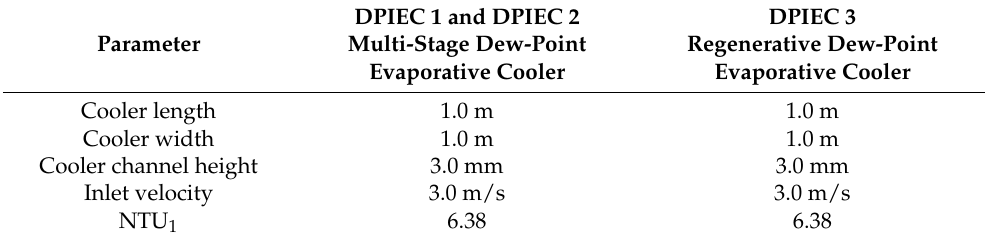
Table 2. Analyzed dew-point evaporative cooler operating